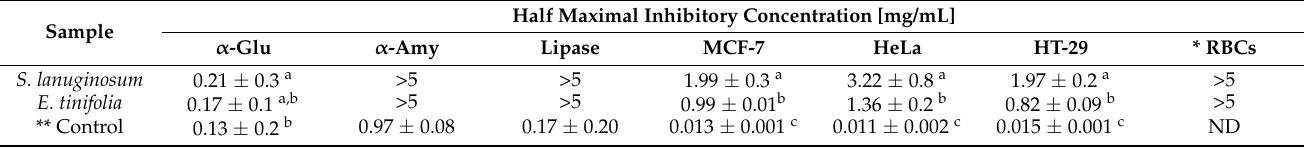
Table 4. Inhibition of digestive enzymatic and antiproliferative activity by E. tinifolia and S. lanuginosum fruit extracts. Half Maximal Inhibitory Concentration [mg/mL] Sample α -Glu α